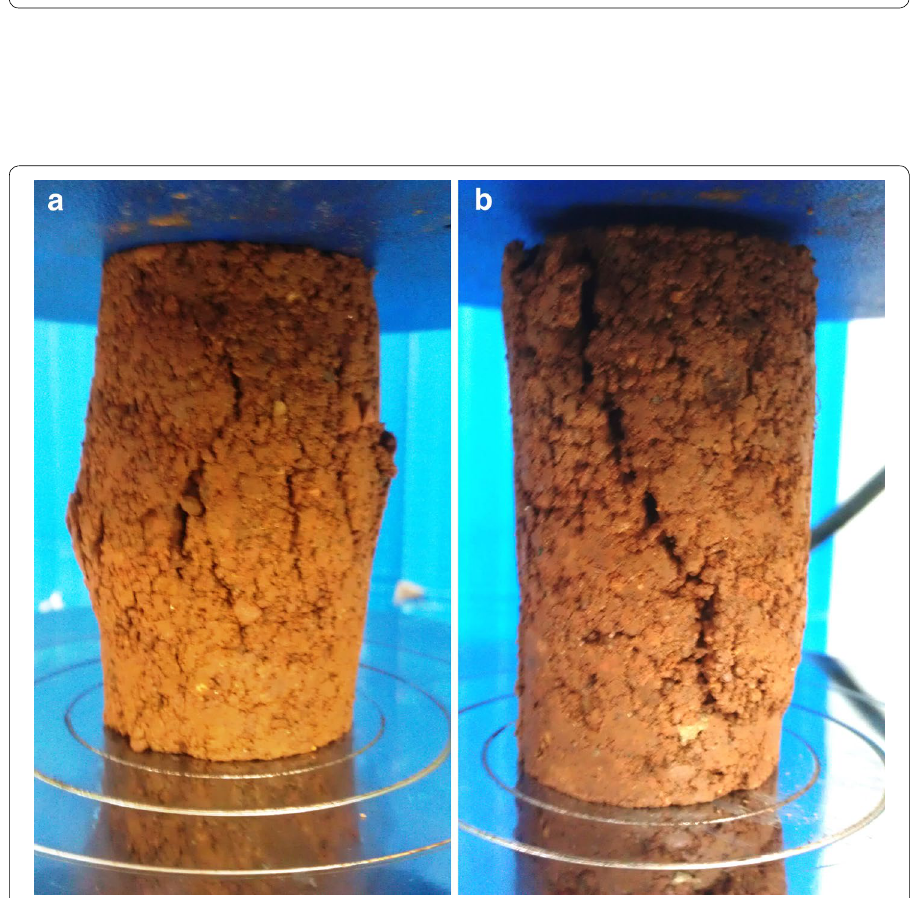
Fig. 6 a Typical shear failure pattern for wet cured specimens. b Typical shear failure pattern for sealed cured